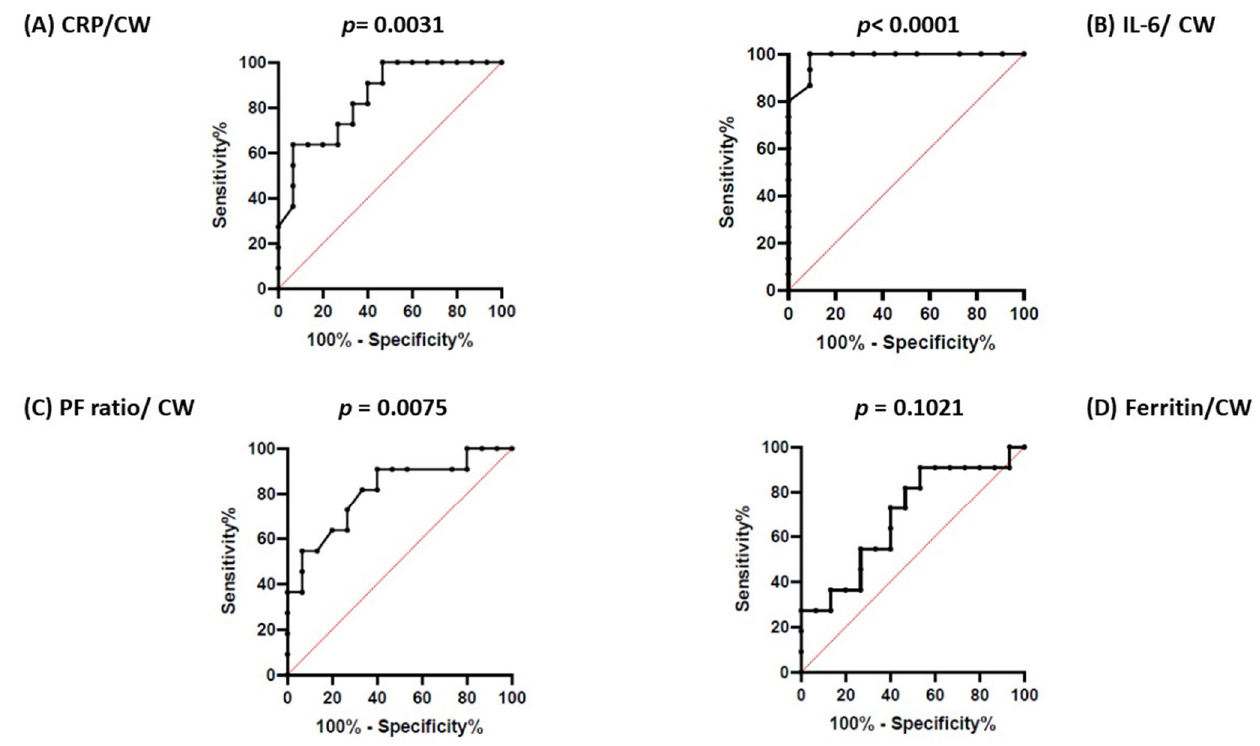
Figure 4. ROC curve analysis for predictors of clinical worsening (CW): CRP ( A ), IL-6 ( B ), and P/F ratio ( C ) resulted in being good predictors of CW. No relationship was found between ferritin at admission and CW ( D ).